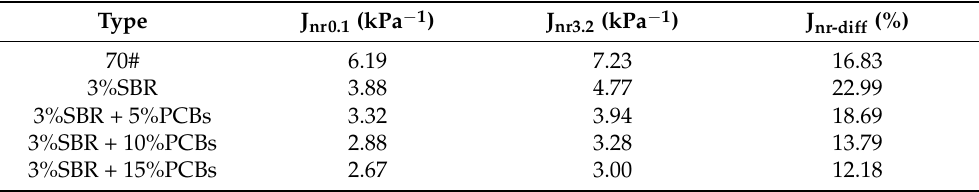
Table 8. Results of irrecoverable compliance at stress levels of 0.1 kPa and 3.2 kPa.